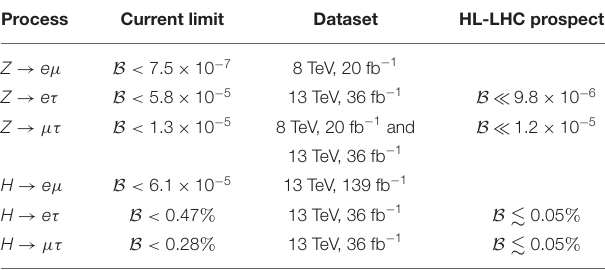
TABLE 1 | Current ATLAS limits on the branching fractions for the LFV decays of Z and Higgs bosons, as obtained at 95% of CL, along with the corresponding